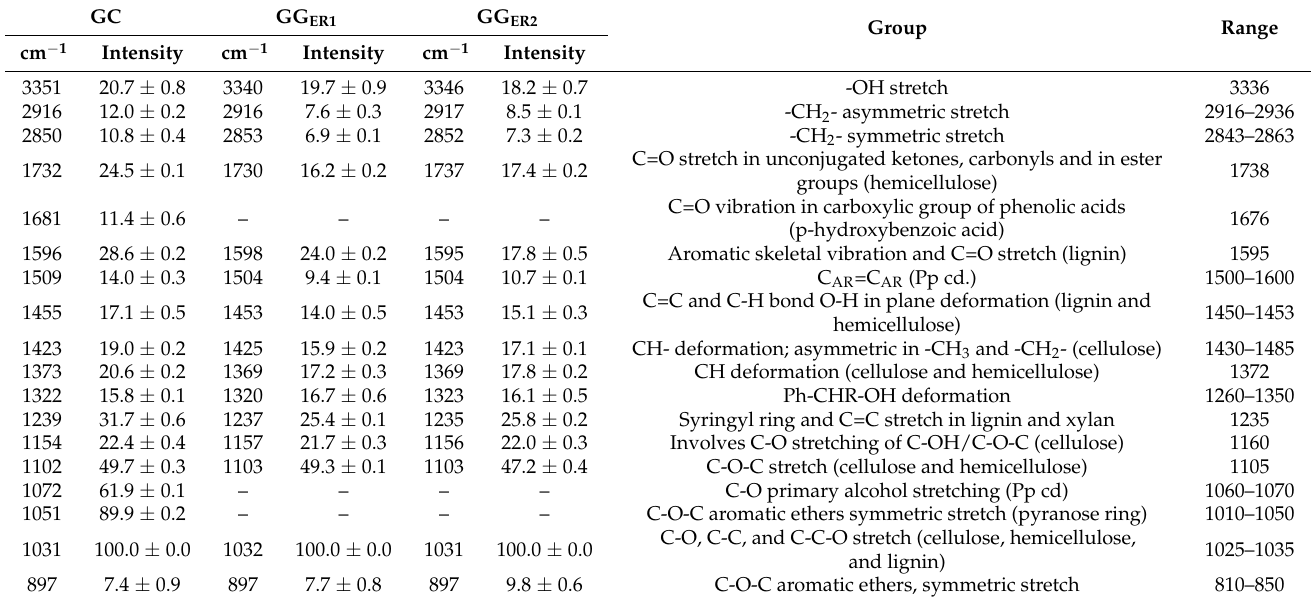
Table 3. FTIR peak assignment of grape cane after and before the extraction process.